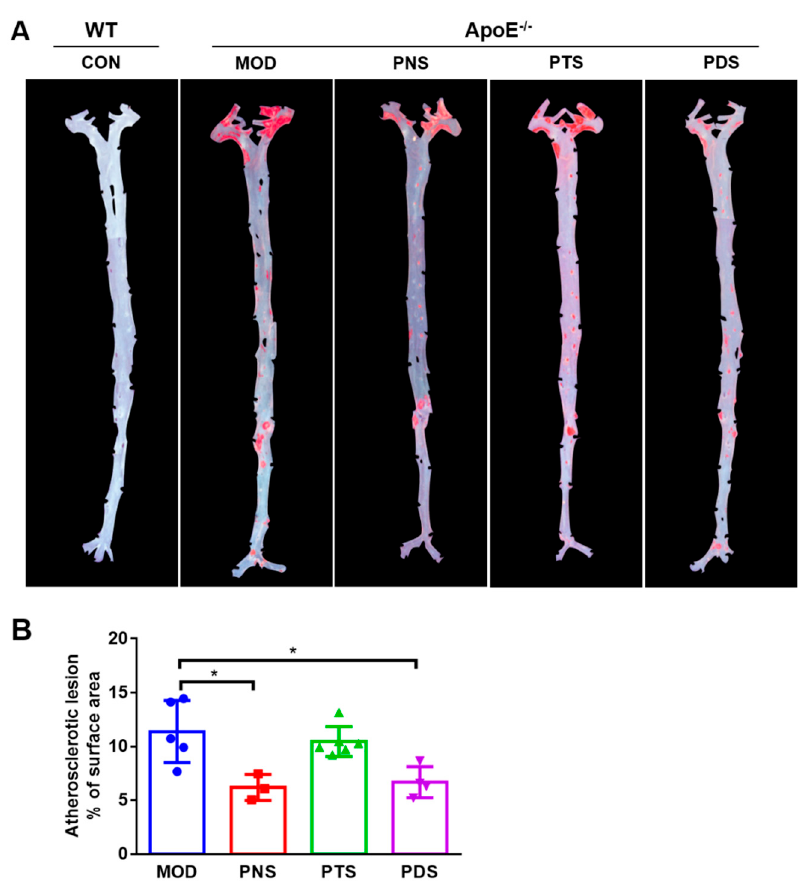
Figure 2. Atherosclerotic lesions in the entire aorta from wild-type mice (CON), untreated ApoE − / − mice (MOD), and PNS / PTS / PDS-treated ApoE − / − mice. ( A ) Representative Oil red O-stained, longitudinally opened aorta, atherosclerotic plaques (red). ( B ) The percentage of the lesion area of the entire aorta. n = 4–6 per group. *, p < 0.05.